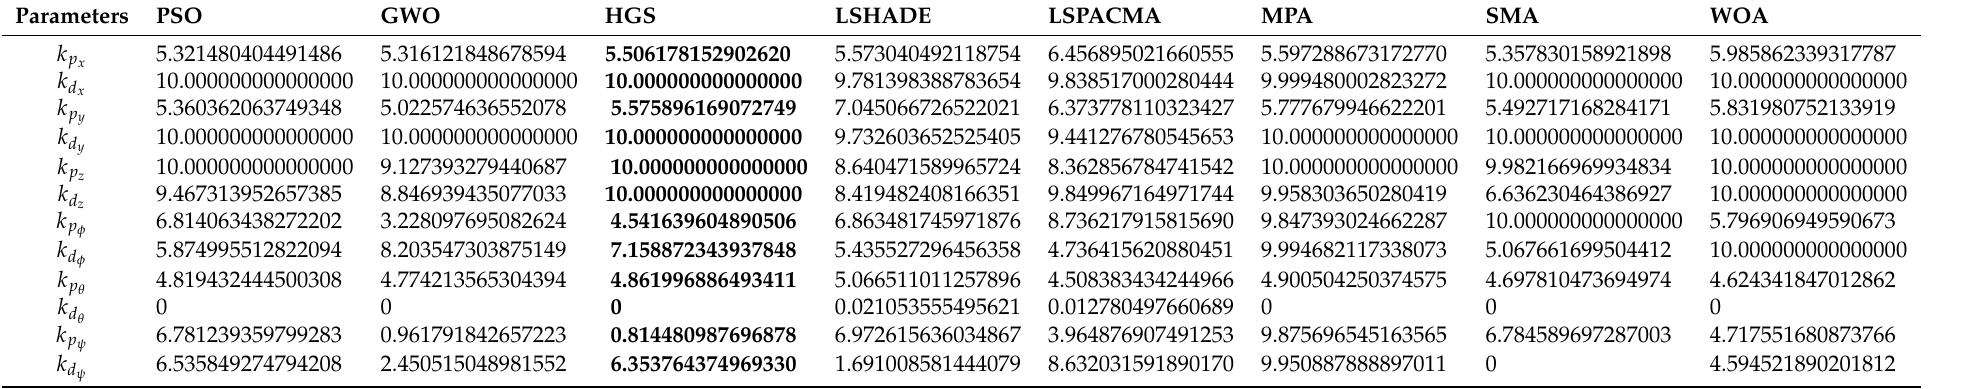
Table 4. The parameter estimation of metaheuristic algorithms with 30 individuals, 20 evolutions and 30 repetitions.